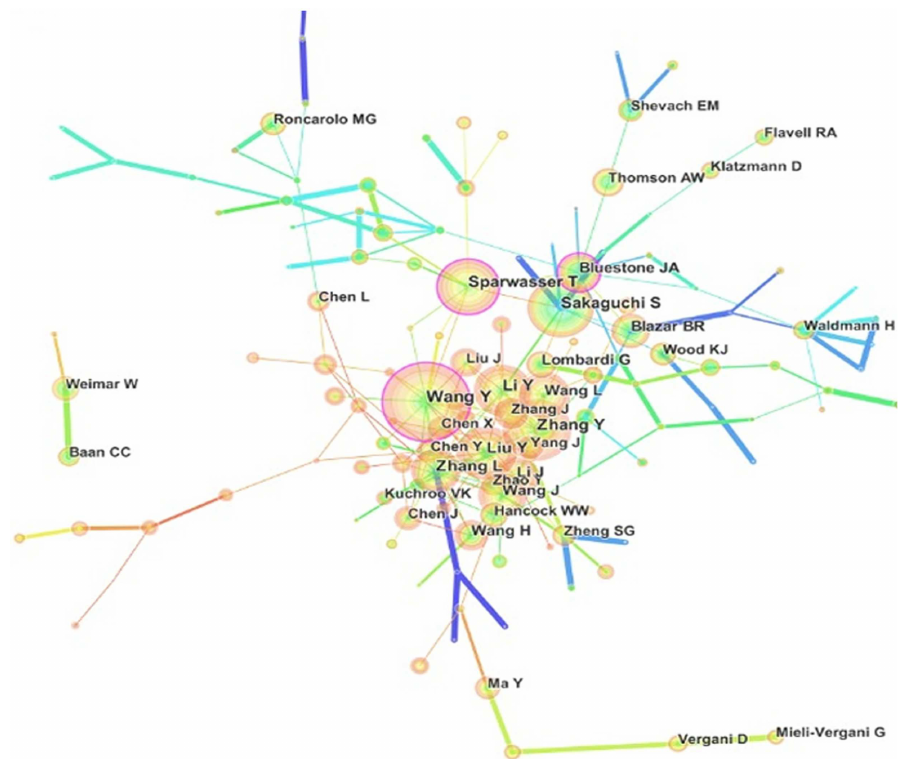
Fig 4. Map of authorswho published articlesrelatedto regulatory T cell (Treg) research.